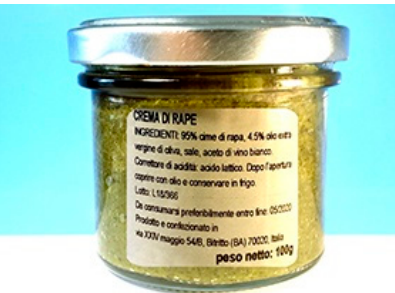
Figure 2. Auctioned Broccoli pesto jar. Note: Beyond the ingredient list (top), the label reported the best before consumption date, producer’s address and net weight (bottom).